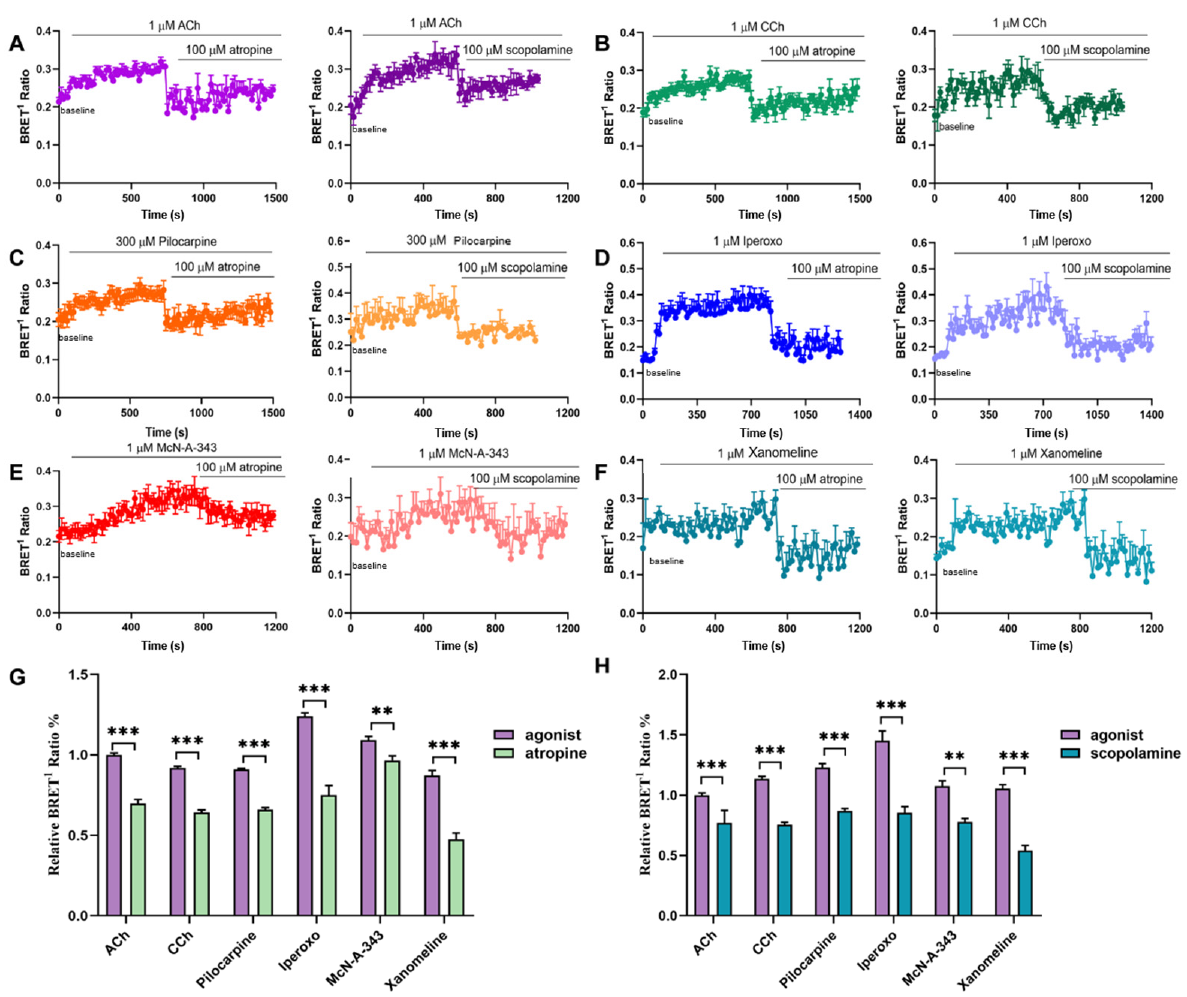
Figure 3. Analysis of antagonist effects of Gq-M1mAChR binding assessed by BRET assays. ( A ) ACh, ( B ) CCh, ( C ) Pilocarpine, ( D ) Iperoxo, ( E ) McN-A-343, ( F ) Xanomeline, ( G ) antagonistic potency of Atropine to agonists, and ( H ) antagonistic potency of Scopolamine to agonists. Data are means ± S.E.M. of 3–8 independent experiments performed in duplicate. The statistical significance of differences between the indicated groups was assessed by two-way ANOVA, where ** p < 0.01, *** p < 0.001.